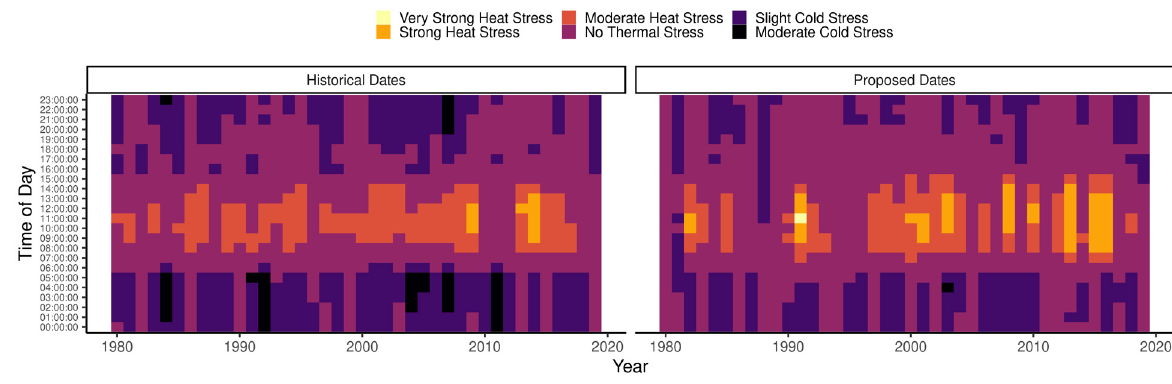
Figure 5: The mean Universal Thermal Comfort Index values for past events and for the proposed date, along the Comrades